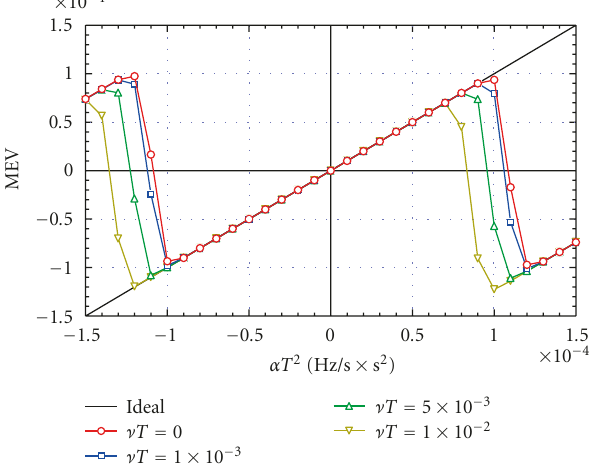
Figure 6: MEV of FREPE estimator for di ff erent values of the Doppler-shift vT —simulation only. Preamble + postamble DA ML phase estimation, N = 44, M = 385, E s /N 0 =